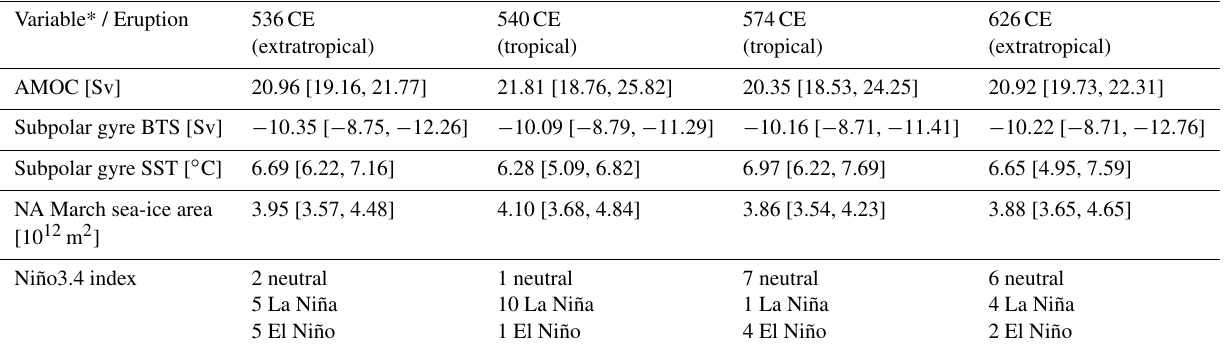
Table A2. Initial ocean and sea-ice conditions. Mean and range of all ensemble members for the AMOC, subpolar gyre BTS and SST, NA March sea-ice area, and ENSO states (Niño3.4 index) before the four large eruptions. *For all quantities the mean of the previous year of the eruptions is calculated except for the Niño3.4 index, for which the 5-month rolling mean (ASOND) of the previous year was taken. Variable* /